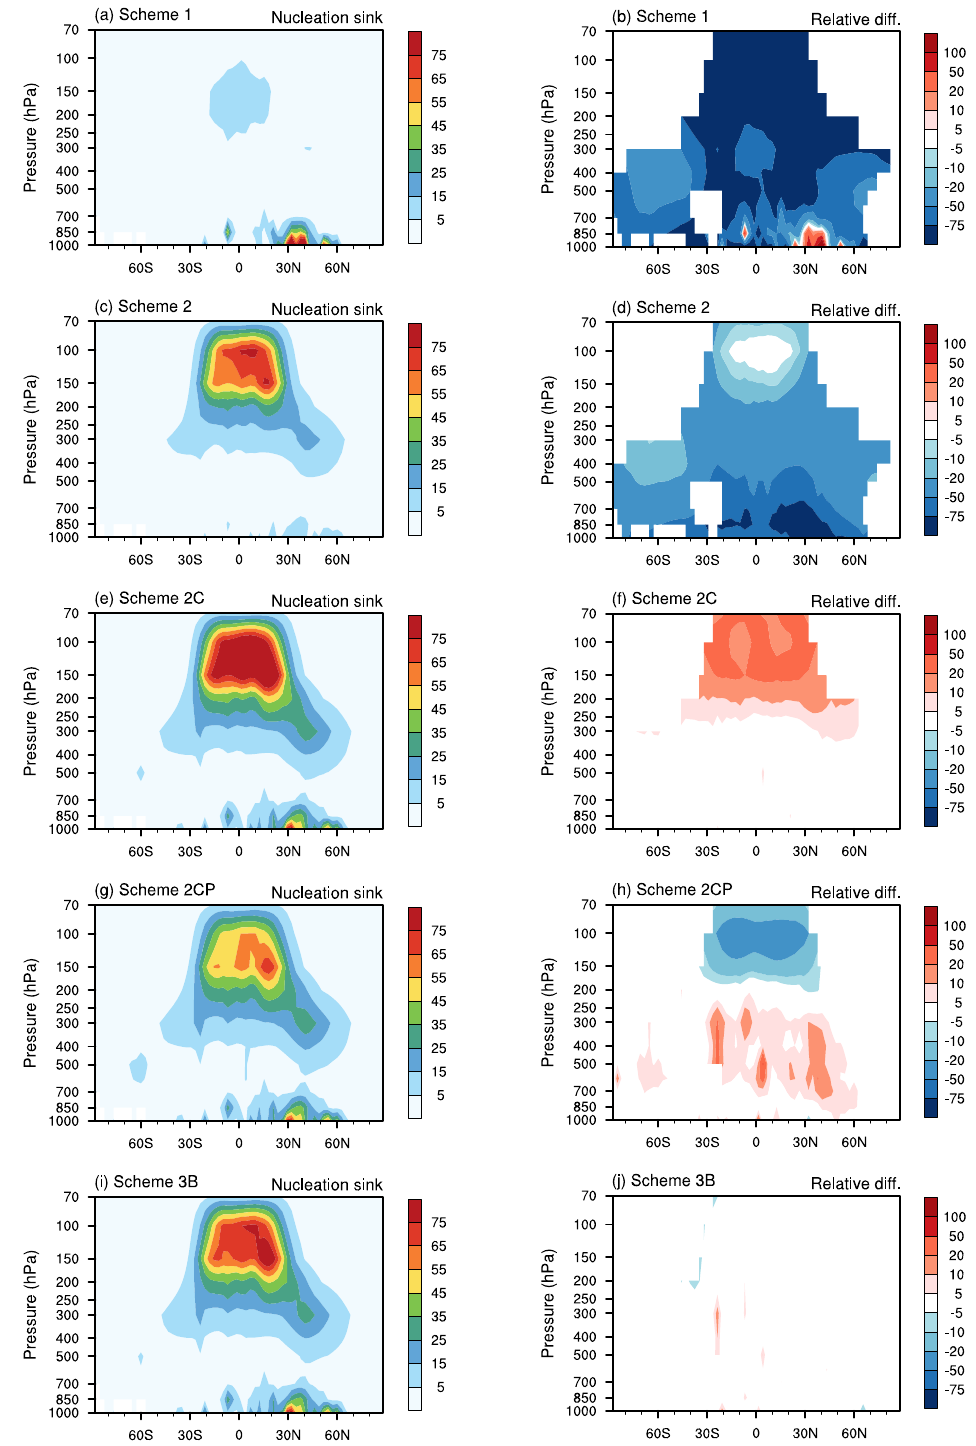
Fig. 7. Left column: zonally and annually averaged H 2 SO 4 gas loss rate due to aerosol nucleation (unit: molecules cm − 3 s − 1 ), simulated using various time stepping scheme with the default time step for model physics (i.e., no sub-stepping). Right column: the corresponding relative differences (unit: %) with regard to the reference solution shown in Fig. 3b. The relative differences are plotted only in regions where the nucleation sink is stronger than 1moleculecm − 3 s − 1 . The numerical schemes are described in Sect. 2.2 and Table